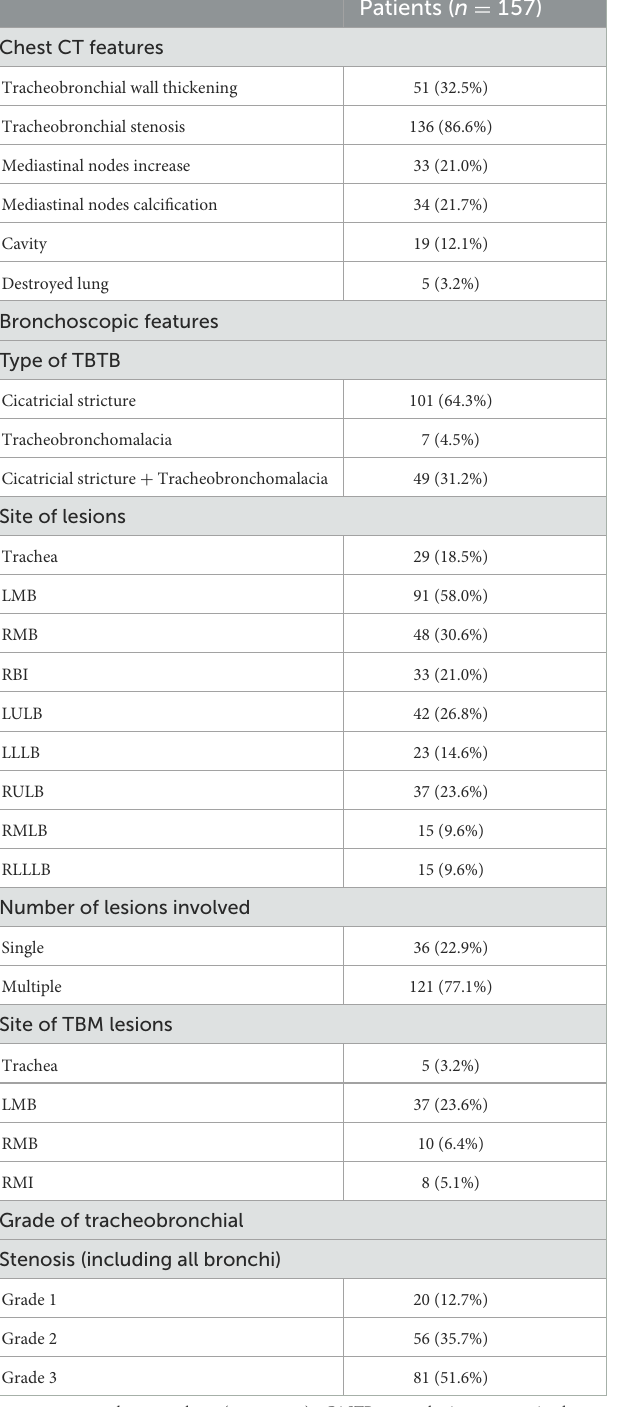
TABLE 2 Chest CT and bronchoscopy features of 157 patients with CASTB. TABLE 3 Comparison of TBM group ( n = 56) vs. non-TBM group ( n = Patients ( n = 157)